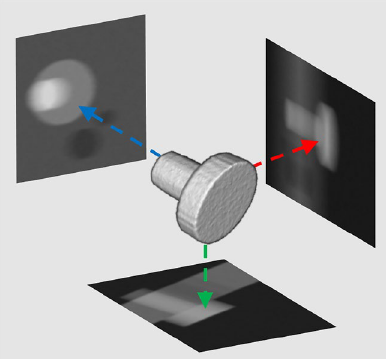
Fig. 2 Perpendicular volume projections from a simulated screw- sample. The simulation also contains a plate and two holes. In order not to obscure the summed projections, the plate is not shown in the 3D model. This figure is supposed to illustrate the transition from volumetric data, to 2D summed